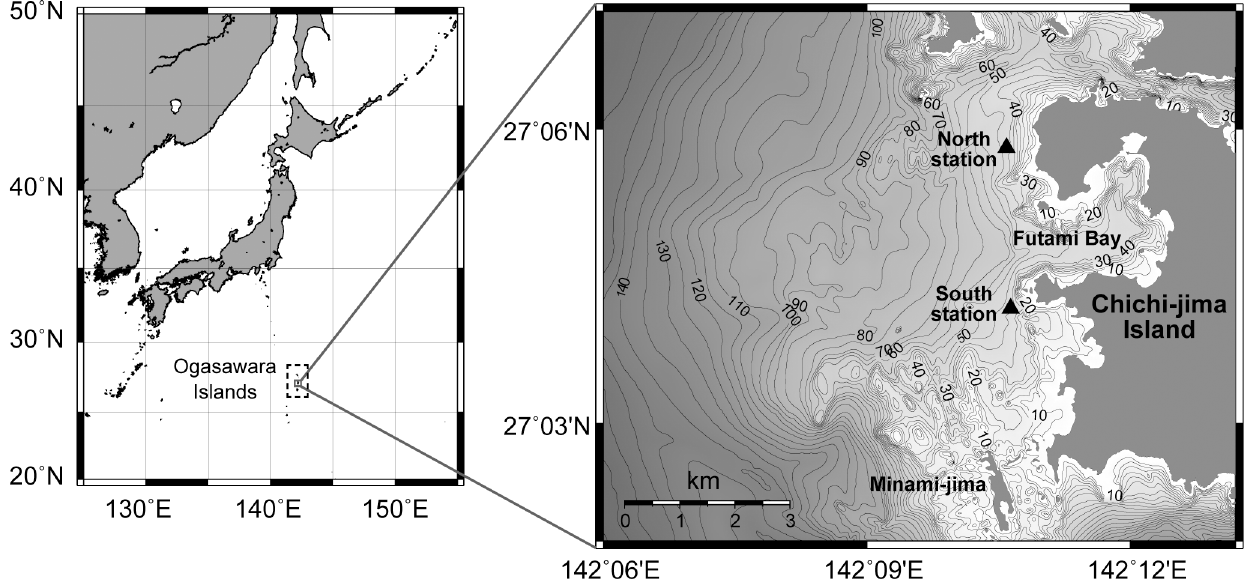
Fig 1. The study site, Chichi-jima Island, Ogasawara, Tokyo, Japan. The Ogasawara Islands are a UNESCO world natural heritage site known to be a major breeding ground of humpback whales of the western North Pacific (Asian) Stock. The north and south stations were deployed at about 40 m depth off the coast of Chichi-jima (black triangle). The recorders were suspended at a depth of 20 m using buoys, with a marker buoy situated at 4 m below the water surface. The bathymetry data was based on the M7023 digital bathymetry chart provided by Japan Hydrographic Association.